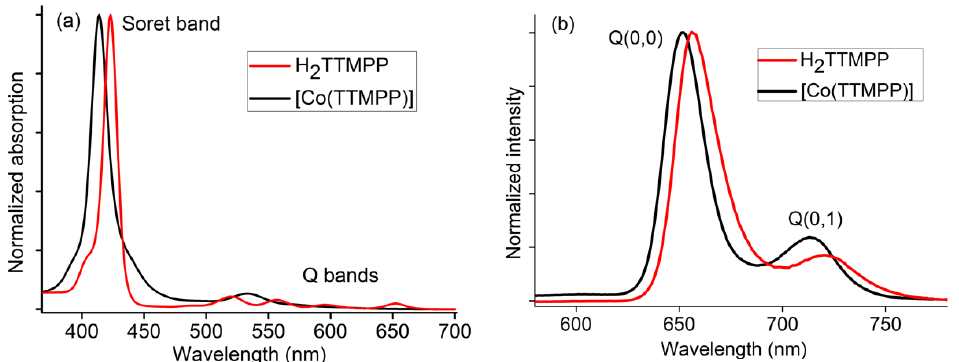
Figure 1. Normalized UV-vis absorption spectra ( a ) and photoluminescence spectra ( λ exc = 430 nm) ( b ) of [Co(TTMPP)] and H 2 TTMPP in CH 2 Cl 2 . Upon excitation at 430 nm, both H 2 TTMPP ( λ max = 658 and 721 nm) and [Co(TTMPP)] ( λ max = 651 and 714 nm) show photoluminescence (PL) in CH 2 Cl 2 at room